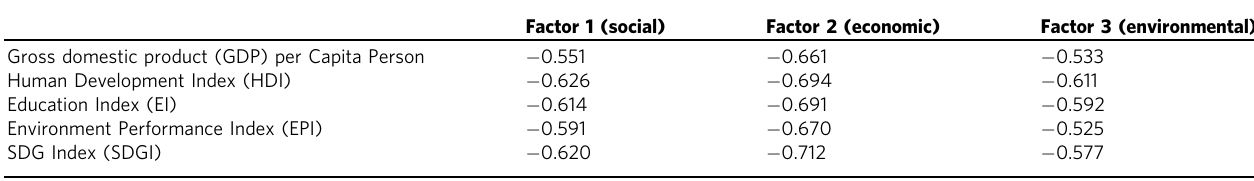
Table 2 Spearman correlations between the three discovered higher-level factors of the factor analysis and the fi ve selected global development